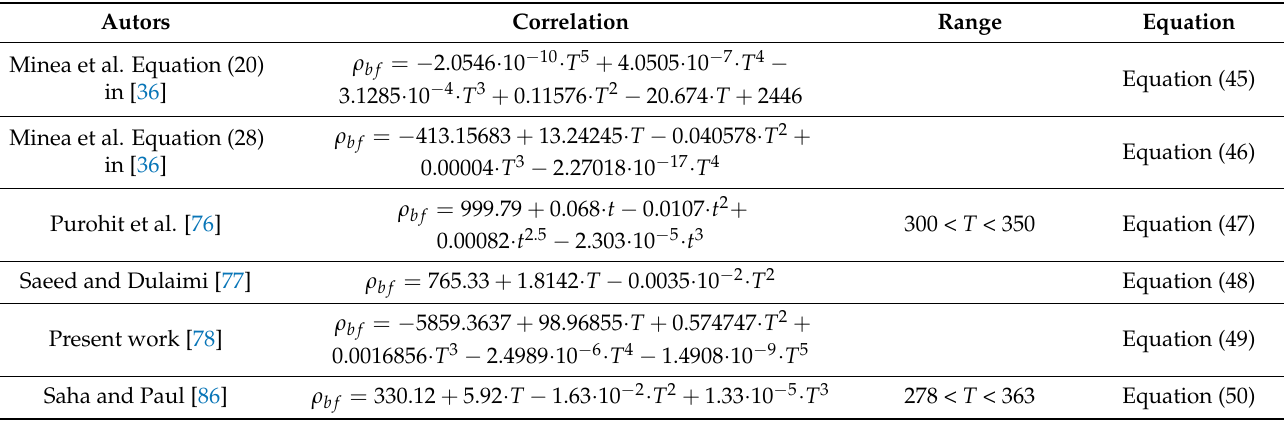
Table 9. Correlations for density of